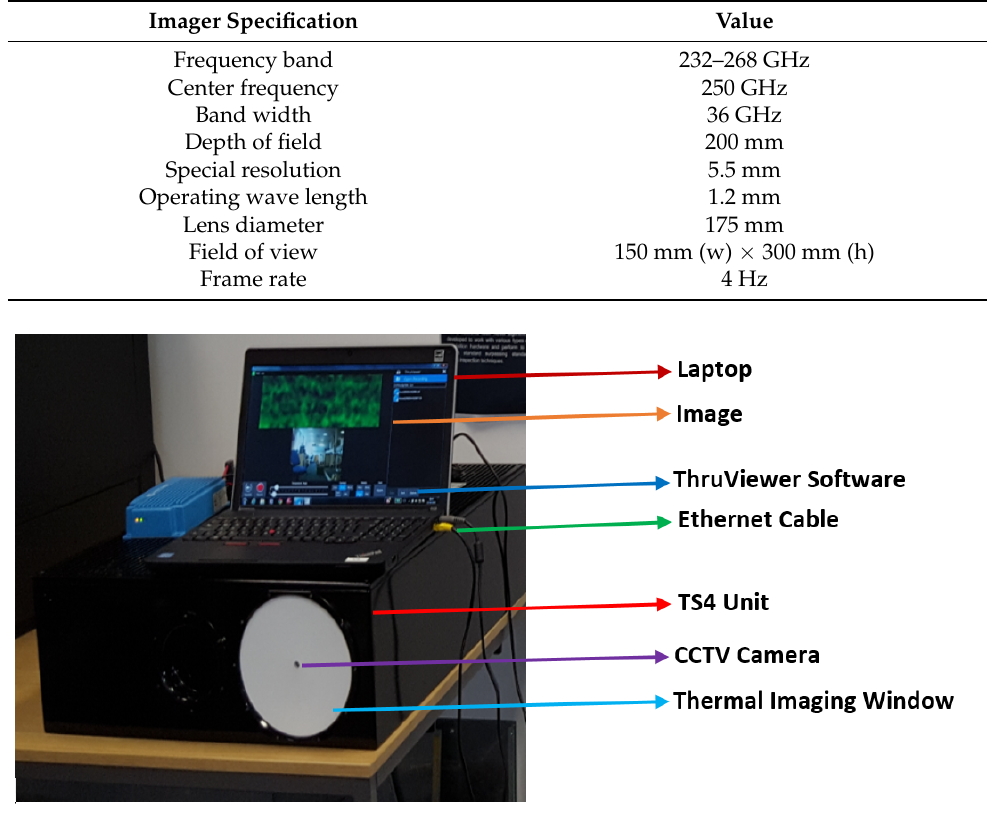
Figure 2. A ThruVision passive imager having a center frequency of 250 GHz comprising a TS4 unit, a CCTV camera, a thermal imaging window, and a laptop with a ThruViewer software. The distance between the imager and the target (i.e., porcine skin sample) is 800 mm. This distance was chosen since it is within the depth of field and the range of the imager (range = 1000 mm). Table 1. A ThruVision passive imager specifications and parameters [49].